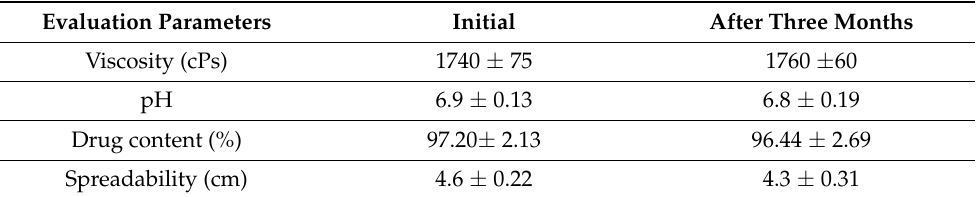
Table 4. Stability data of optimized levosulpiride-loaded niosomal gel. Each value depicts the average and standard deviation of different batches (n =